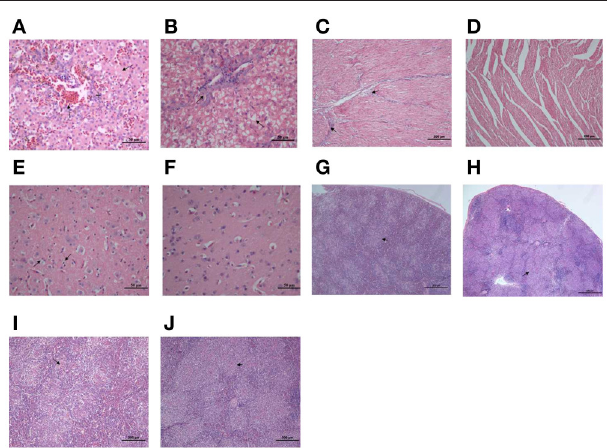
FIGURE 4 | Histopathological analysis of the duck tissues. Liver, heart, brain, and spleen samples were collected from the infected ducks with R. anatipestifer YM strain (A,C,E,G,I) or YM 1 RS09735/RS09740 strain (B,D,F,H,J) in 48 h post-challenge, fixed in 10% formalin, and subjected to hematoxylin and eosin staining for a histopathological examination. The “arrow” represents the obvious pathologic change in tissues.